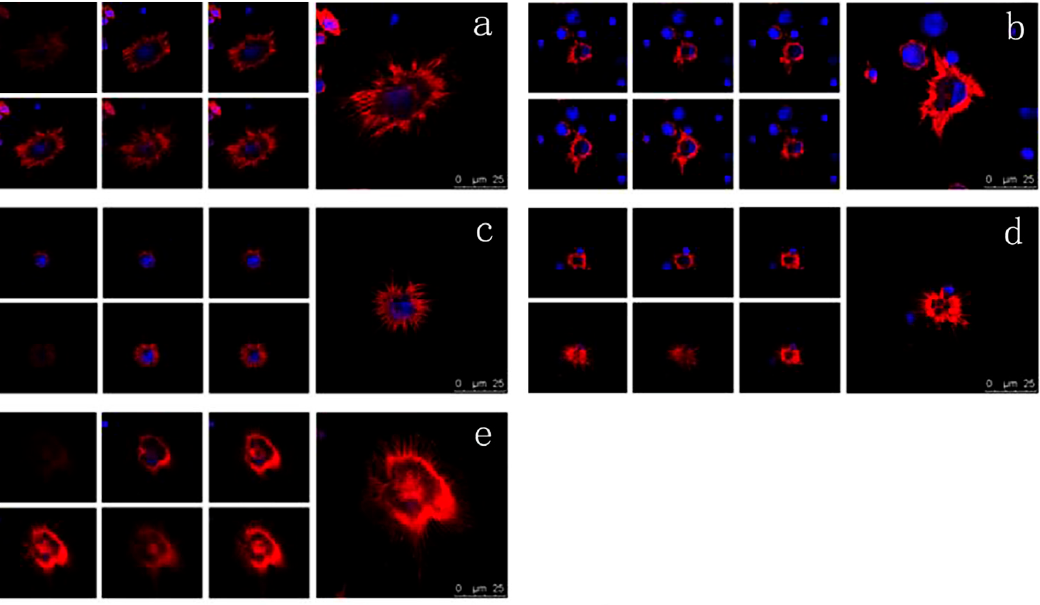
Figure 6. Confocal microscope analysis of F-actin organization of mDCs treated with different concentrations of VEGF (×600). ( a ) control; ( b ) 10 ng/mL; ( c ) 30 ng/mL; ( d ) 50 ng/mL; ( e ) 70 ng/mL.